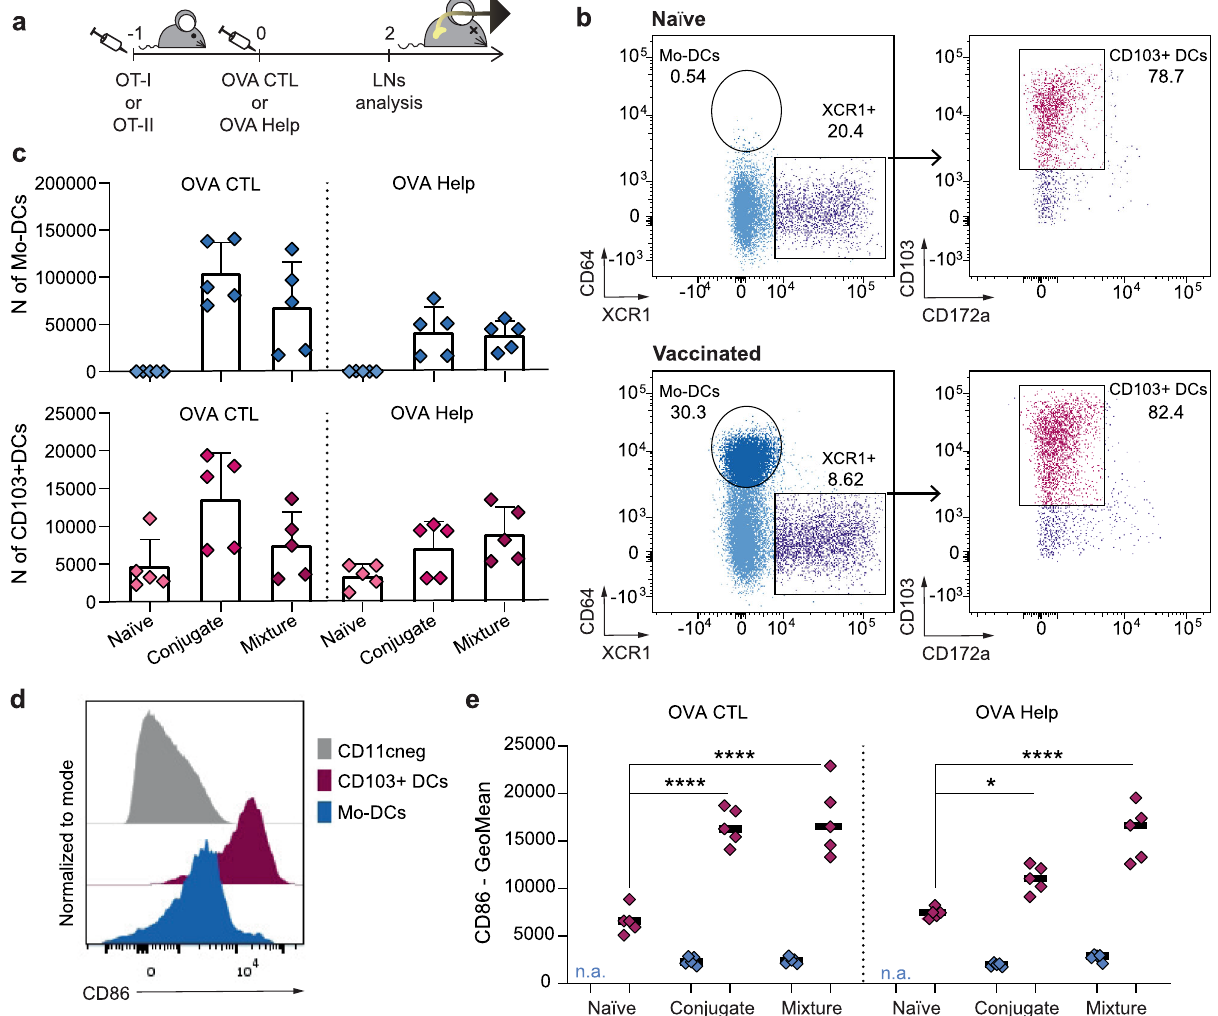
Fig. 2 OVA CTL and Help peptide conjugated to CRX-527 promote DCs in fl ux in the draining lymph node upon in vivo injection. a Mice ( n = 5 per group) were adoptively transferred with CFSE labeled OT-I or OT-II cells 24 h before intradermally receiving 2 nmol of OVA CTL or Help CRX-527 conjugates, or an equimolar mix of peptide and CRX-527. 48 h later the inguinal lymph nodes were harvested for analysis. b Representative dot plots for the gating of Mo-DCs and CD103 + dermal DCs in naïve versus vaccinated mice. Cells were pre-gated to exclude dead/CD19 neg /CD11c neg /MHC class II neg cells ( c ). Absolute count of Mo-DCs and XCR1 + /CD103 + DCs in the inguinal lymph nodes ( d ). Representative histograms of CD86 expression in non-APCs (CD11c neg ), Mo-DCs or XCR1 + /CD103 + DCs. e Fluorescence intensity of CD86 signal (GeoMean) in Mo-DCs and XCR1 + /CD103 + DCs subsets upon vaccination. Statistical signi fi cance was determined by one-way ANOVA followed by Tukey ’ s multiple comparison test; * p < 0.05, ***** p < 0.0001; data are displayed as mean ±